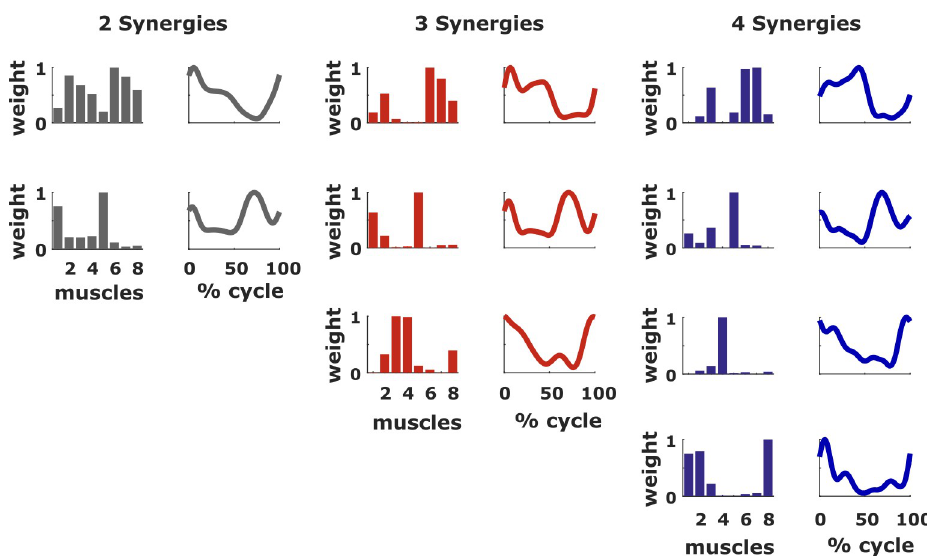
Fig 4. Composition of the generic synergies. Weights and activations for the extracted sets of generic synergies. Muscle names: 1 Rectus femoris, 2 Vastus lateralis, 3 Biceps femoris, 4 medial hamstrings, 5 Tibialis anterior, 6 Gastrocnemius, 7 Soleus, 8 Gluteus